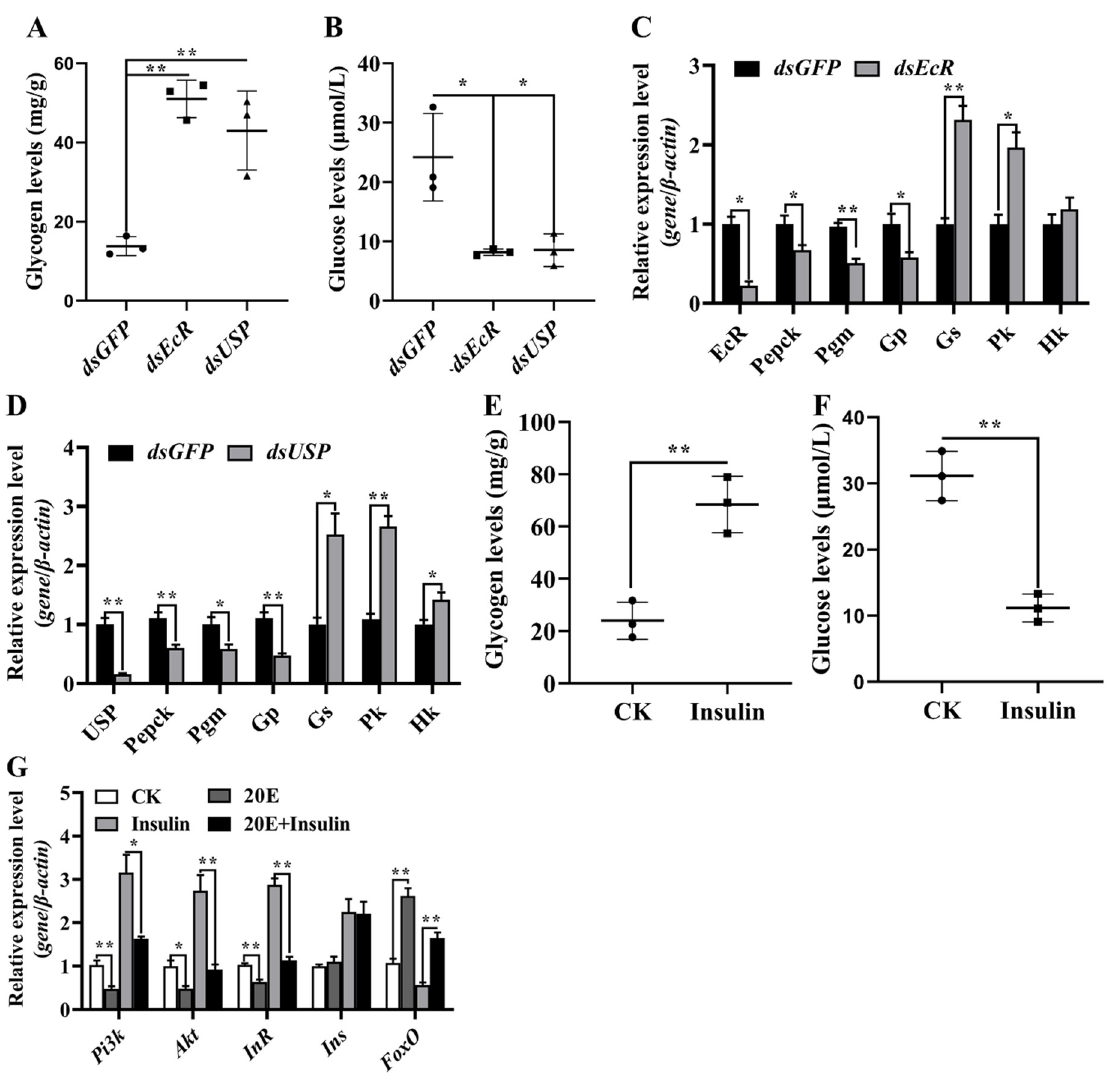
Figure 9. Variation in the levels of metabolites and related gene expression after EcR and USP were knocked down in larvae. ( A , B ) Glycogen levels in the fat body and glucose levels in the hemolymph after first injection of dsEcR and dsUSP for 48 h. ( C , D ) Changes in the expression levels of certain genes after EcR and USP knockdown by injection of dsRNA, as detected using qRT-PCR. ( E , F ) Variation in the levels of metabolites after insulin treatment. ( G ) Variation in the levels of related gene expression after 20E treatment. The error bars indicate the mean ± SEM of three times repetition. The asterisks indicate significant differences from the control group (*, p < 0.05; **, p < 0.001) by using the Student’s t -test.